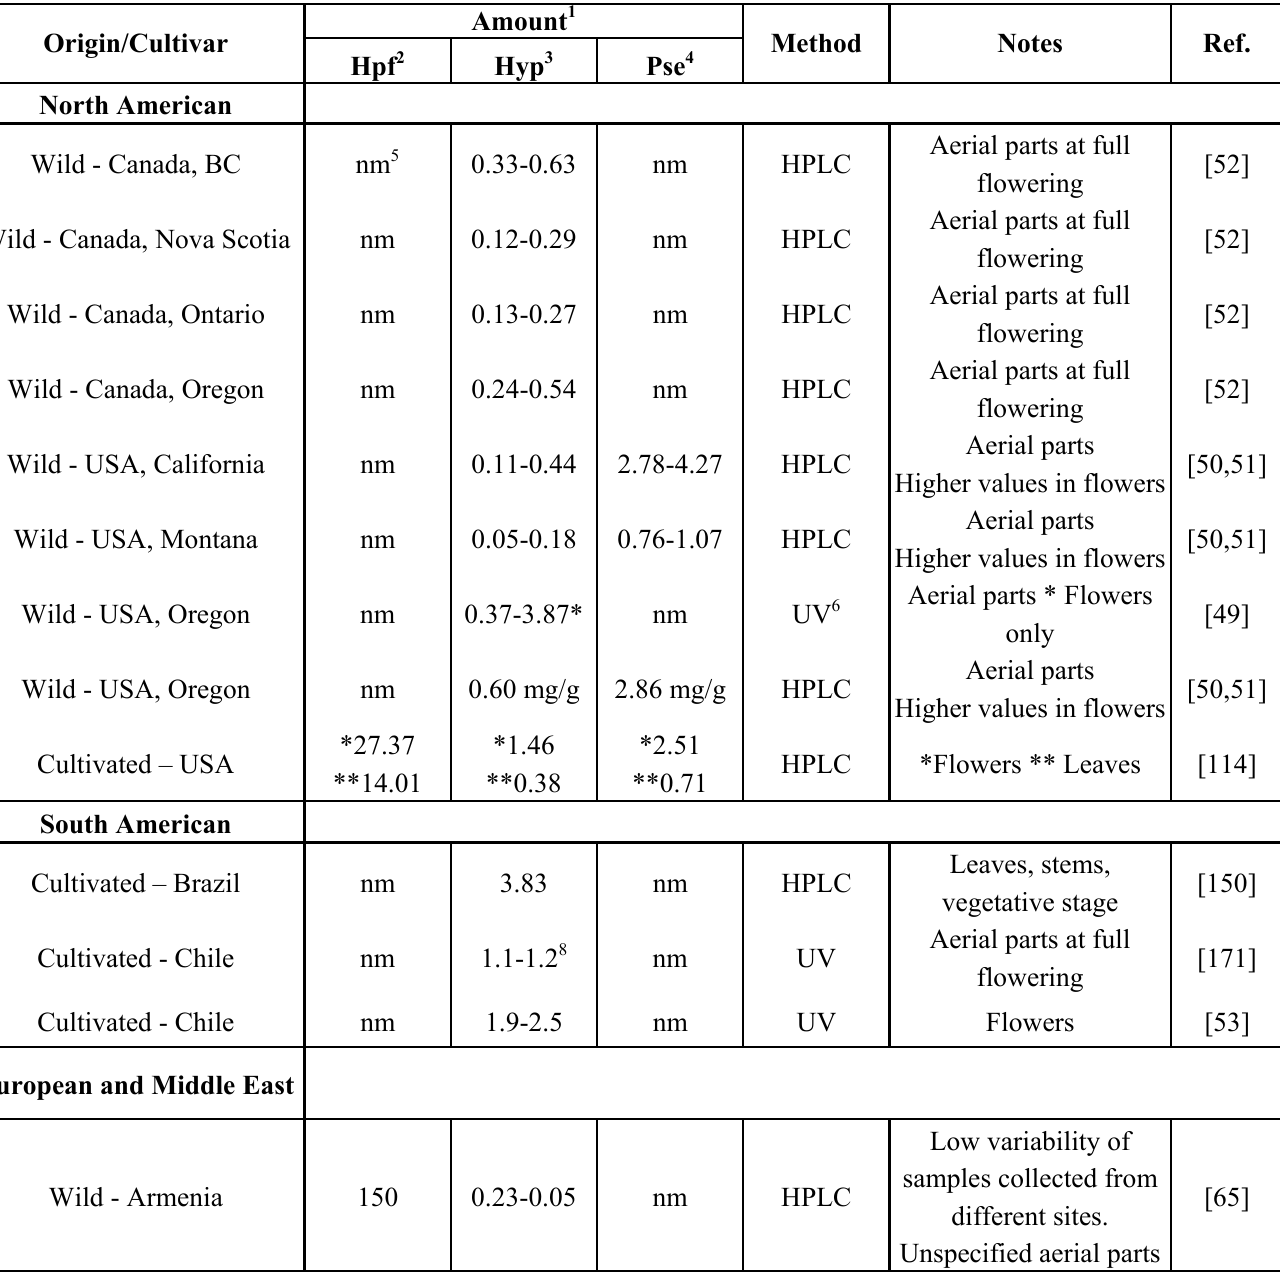
Table 2. Amount of hyperforin (Hpf), hypericin (Hyp) and pseudohypericin (Pse) in vegetative and reproductive parts of wild and cultivated H.perforatum and related cultivars of different geographic